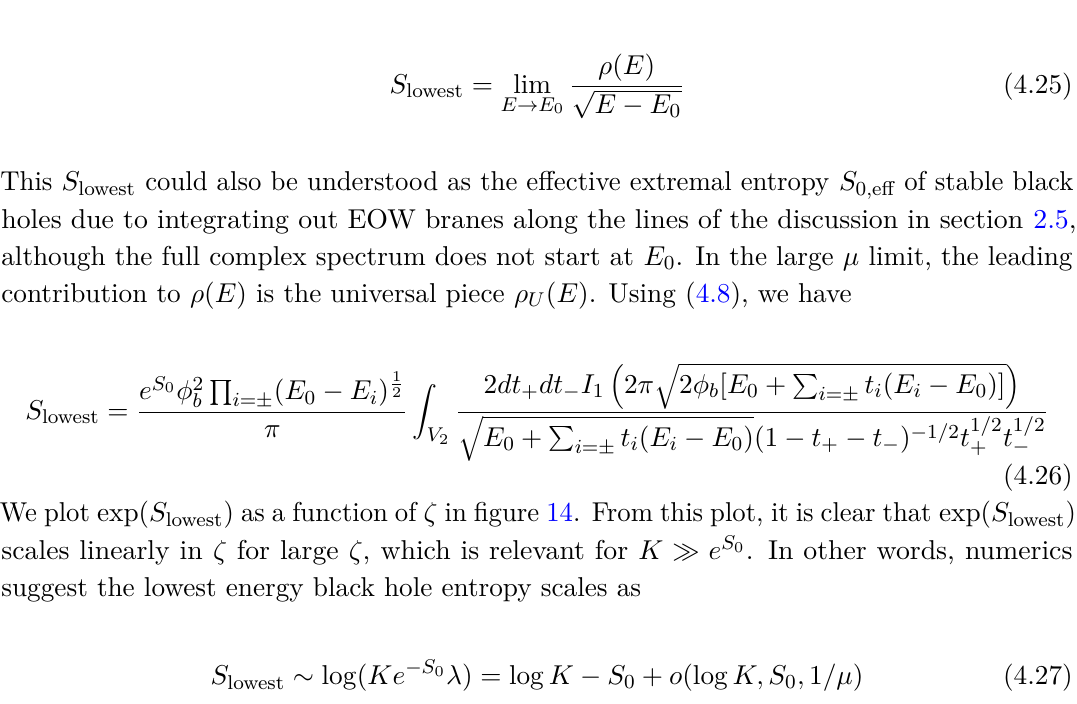
Figure 14. exp( S lowest ) as a function of ζ . In this plot, we set 2 is clear that exp( S lowest ) scales linearly in ζ for large ζ